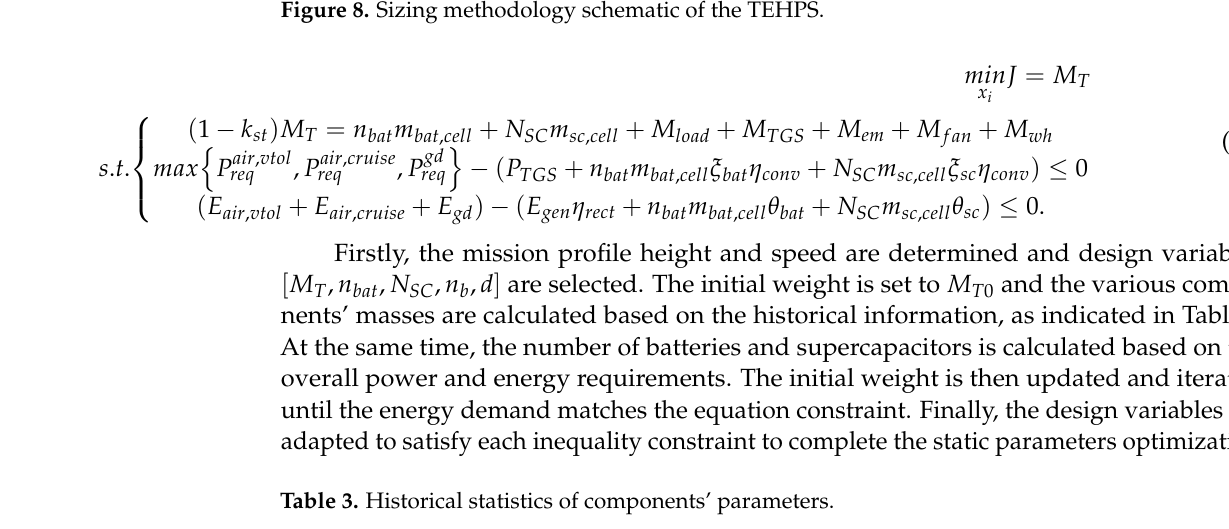
Figure 8. Sizing methodology schematic of the TEHPS.